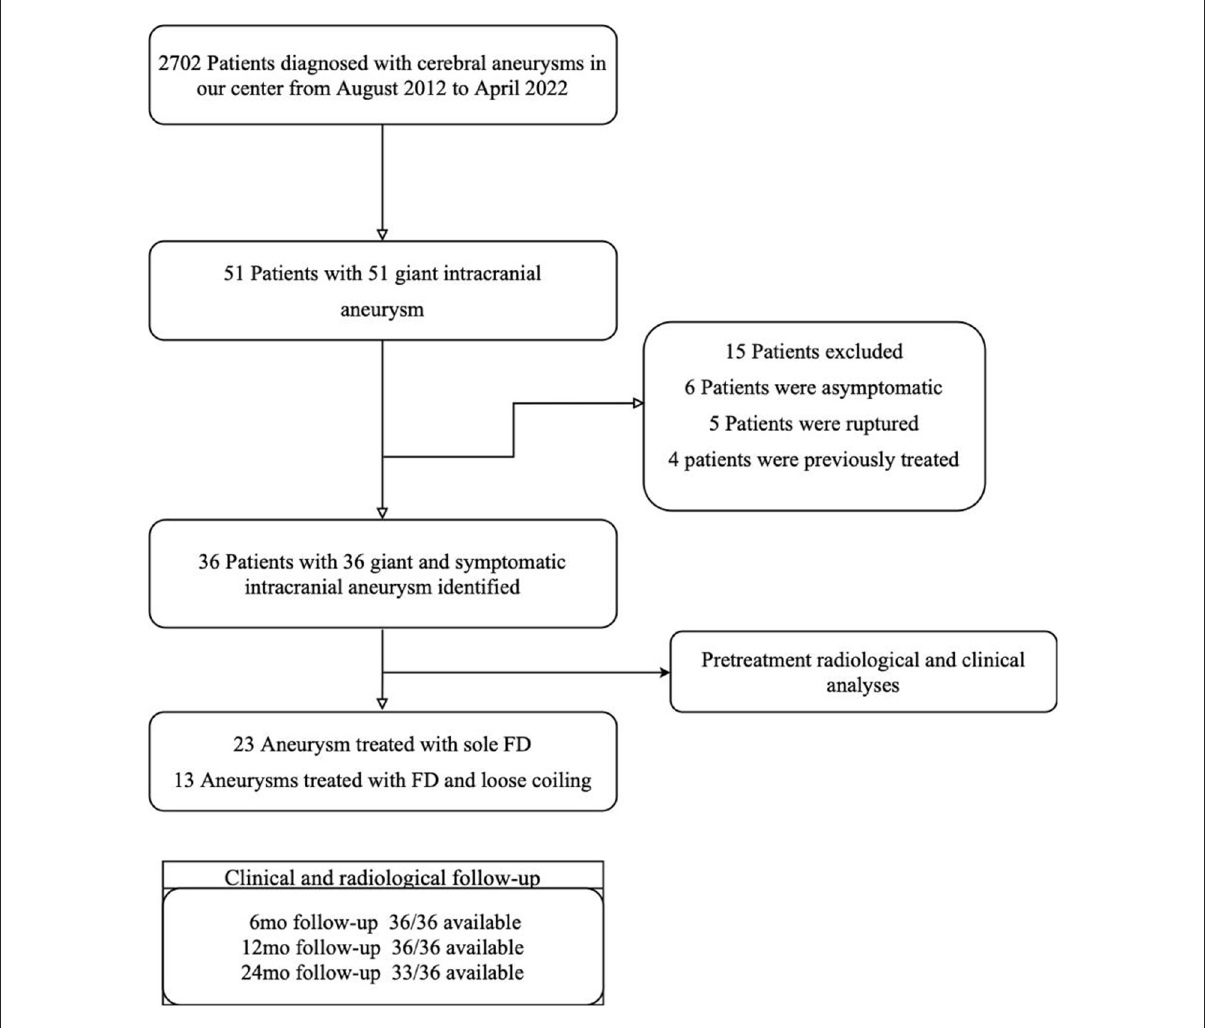
FIGURE1 Illustrative flow chart of study design and